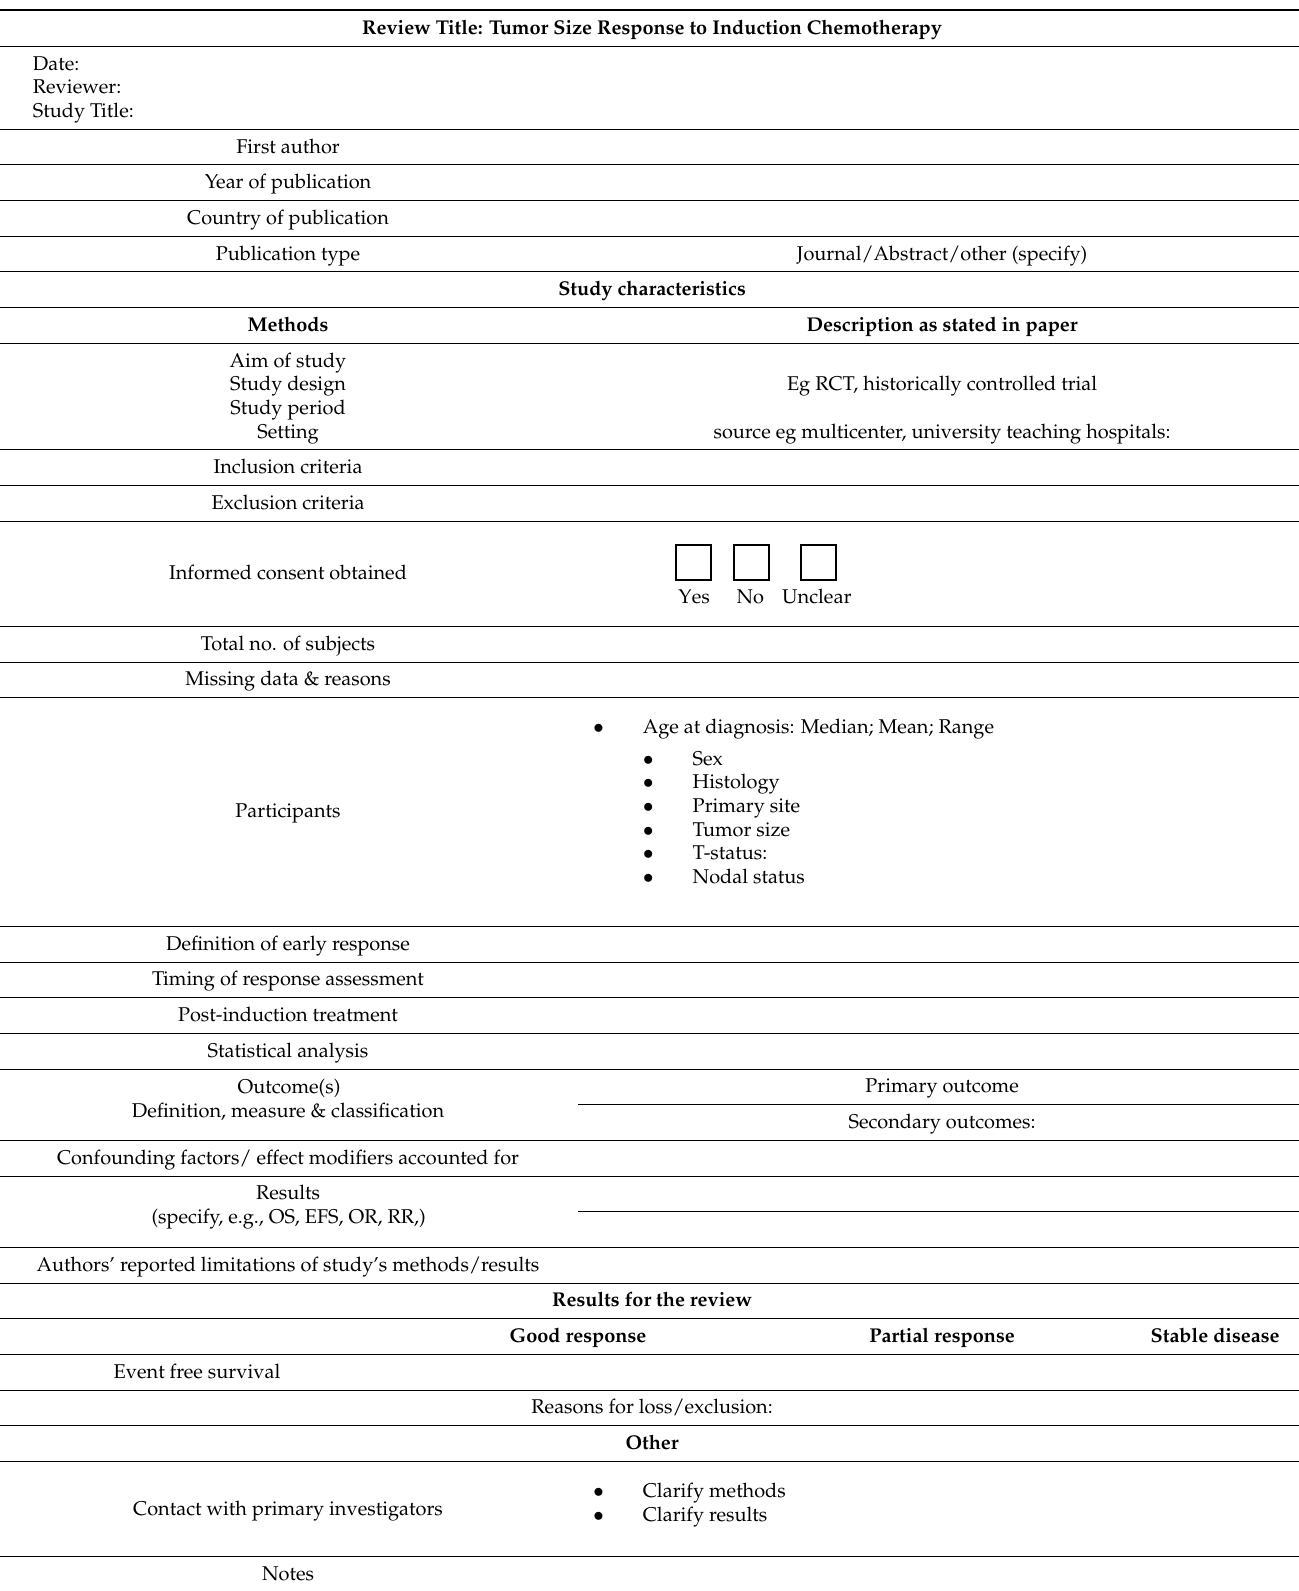
Table A1. Data Extraction form.